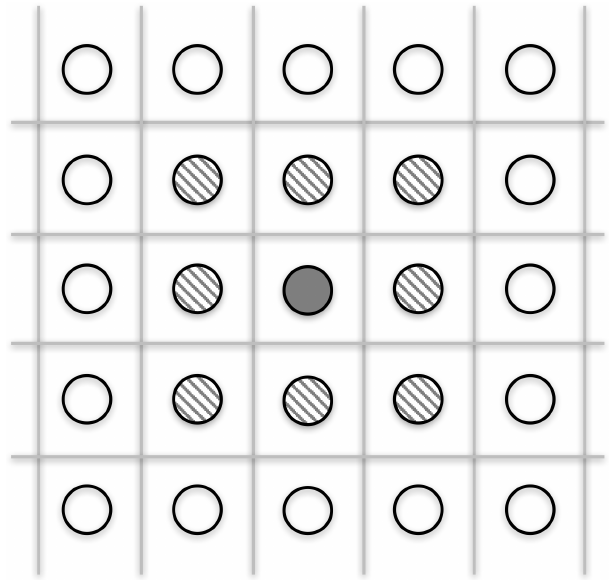
Figure A1. The local neighborhood of a central node (shaded) typi- cally refers to the surrounding eight nodes (diagonal hatching). The periphery, used by Tsutsui and Kasahara (1996), refers to the set of nodes that surround the local neighborhood (unshaded